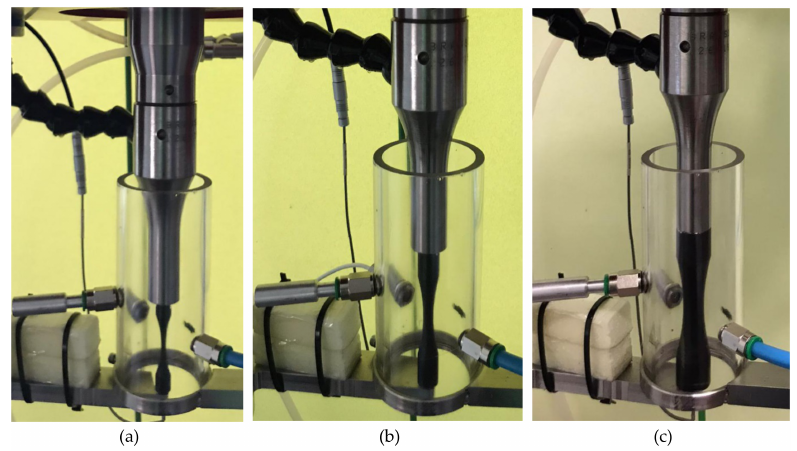
Figure 6. The three tested hourglass specimens: ( a ) 3 mm; ( b ) 6 mm; ( c ) 12